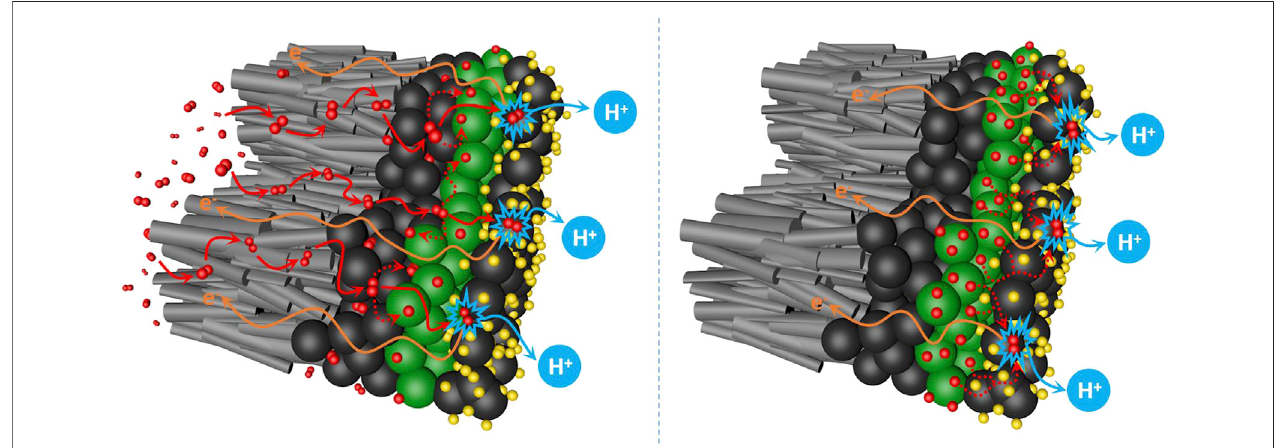
FIGURE 7 | Schematic of TiVCr layer mitigating the